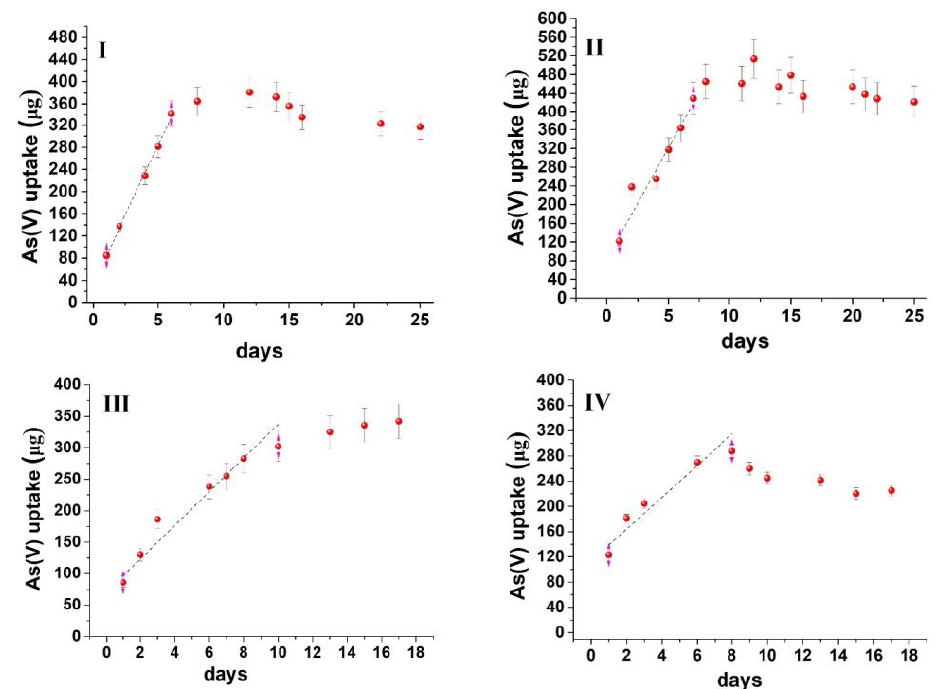
Figure 3. Time series uptake data of As(V) oxyanion on MOR−1 @cotton fabric. ( I ) River water mixed at 50 rpm, ( II ) River water mixed at 150 rpm, ( III ) Lake water mixed at 50 rpm, ( IV ) Lake water mixed at 150 rpm.